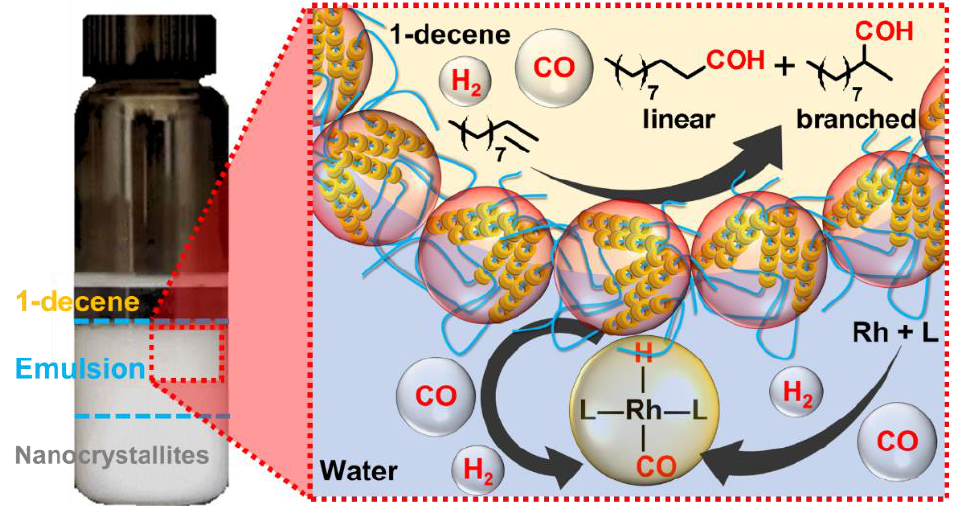
Figure 62. A schematic representation of the Rh-catalyzed hydroformylation of 1-decene in a 1-decene-in-water Pickering emulsion stabilized with α-CD/PEG nanocrystallites (L = TPPTS).